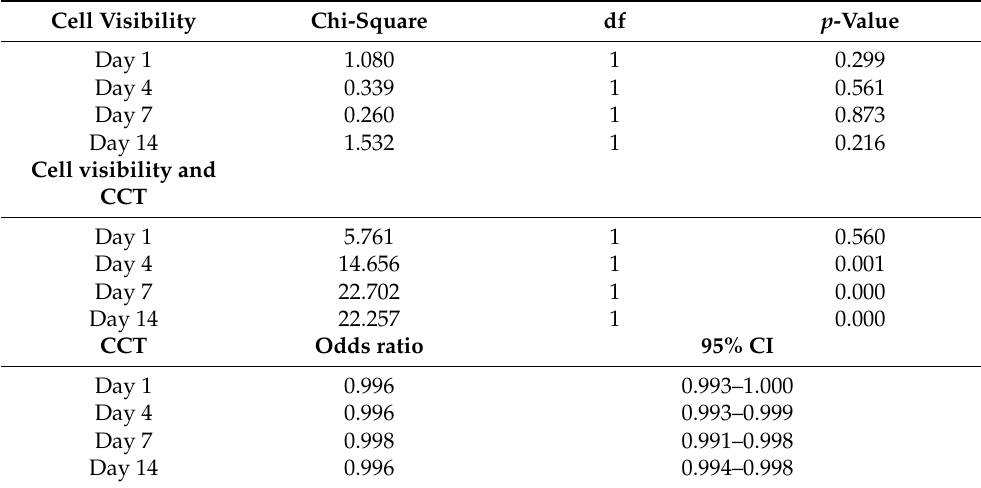
Table 2. Logistic regression modelling of the effect of cell visibility and pachymetry on successful corneal deturgescence and odds ratio of increased CCT predicting a decreased likelihood of successful corneal